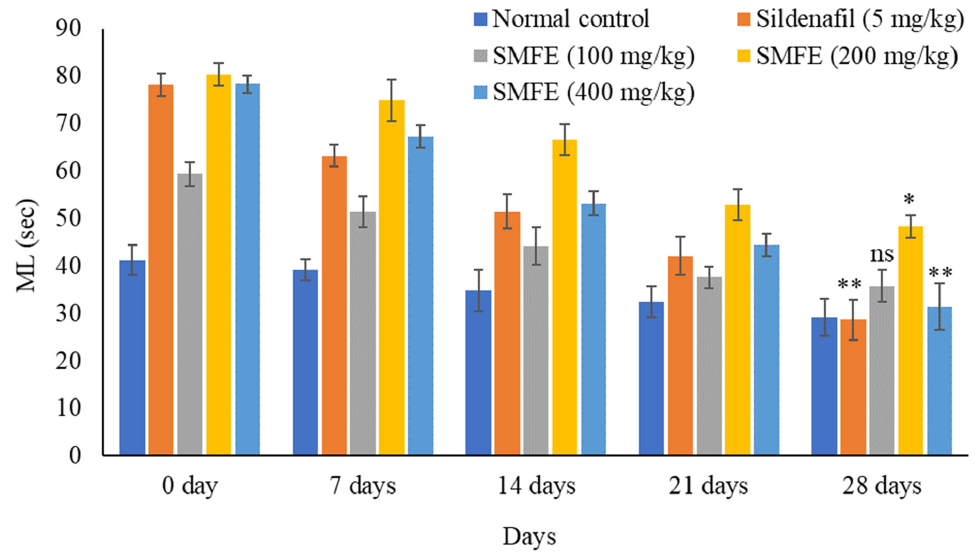
Figure 5. Effect of S. mangifera fruit extract on mount latency ( n = 6). The values are means ± SEM; * p < 0.05, ** p < 0.1; ns p > 0.05 (followed by Student Dunnett test).